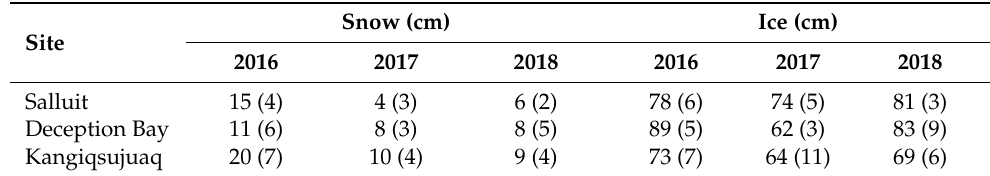
Table 2. Mean January–February snow depth and ice thickness with standard deviations in parentheses.